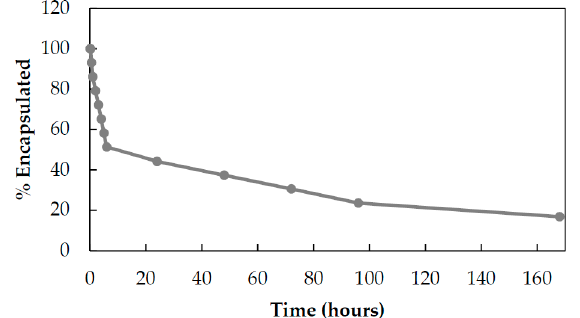
Figure 4. Drug release from HEve nanoparticles. The kinetics of Eve release from HFn nanocages was determined by UHPLC-MS/MS quantifying the amount of Eve released at 37 °C in PBS buffer.